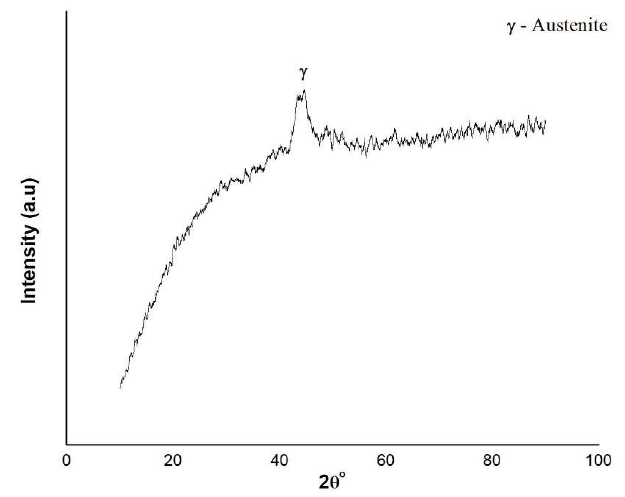
Figure 8. X-ray diffraction pattern for milled powder. Figure 9a represents the TEM microstructure of the vacuum hot pressed steel. Within the austenitic grain, twins were available which indicates the presence of an austenitic matrix. Face centered cubic crystal alloys have a tendency to form twins within the micro- structure when subjected to cold working and annealing as a result of low stacking fault energy. Due to low stacking faults, the energy required for twin formation is lower when compared to grain boundary formation. These kinds of fine austenitic twins are found as the material is subjected to cold working and annealing during ball milling and vacuum hot pressing, respectively. Few dislocations were also found within the grains due to hot pressing. The formation of nano crystalline grains along with dislocations is the outcome of severe plastic deformation. The dislocations are pinned at the grain boundaries. This is due to the presence of metal carbides which are present at the grain boundaries that resist dislocation due to the precipitate strengthening mechanism. These precipitates will im- pede movement or dislocation and resists plastic deformation. Due to MA, the powders consists of residual stresses which act as sites for nucleation [33]. During sintering, these powders nucleates and give rise to the particle stimulated nucleation phenomenon. Face centered cubic structures are found to have particle stimulated nucleation. As the holding time during sintering is 2 h, some grains nucleate near the grain boundaries. This is be- cause a favorable place for grain nucleation is near the grain boundaries which are also the locations for rapid diffusion when compared to a lattice. From Figure 9a, few grains are seen in between the grain and grain boundary region. Grain sizes of the TEM samples were determined by the method of linear intercept. The mean grain size of 1 μm was ob- tained for the samples developed through vacuum hot pressing as shown in Figure 9b. Cast products with similar compositions had large precipitates of carbides along with σ- phases which were not visible near the grain boundary in the current study [3]. Due to the particle stimulated nucleation phenomenon, very few residual carbides were seen within the metal matrix along with the formation of grains and grain boundaries. Similarly, as the material was manufactured using MA and subsequently consolidated using hot press- ing, σ-phases and other intermetallics were not visible as sintering took place under a vacuum atmosphere. The selected area diffraction (SAD) pattern, as shown in Figure 9c, indicates the formation of a nanocrystalline structure even after the consolidation of MA powders at 1200 °C. The rings represent the formation of nano crystallite structures of the metal matrix. Correspondingly, the outer ring represents the formation of face centered